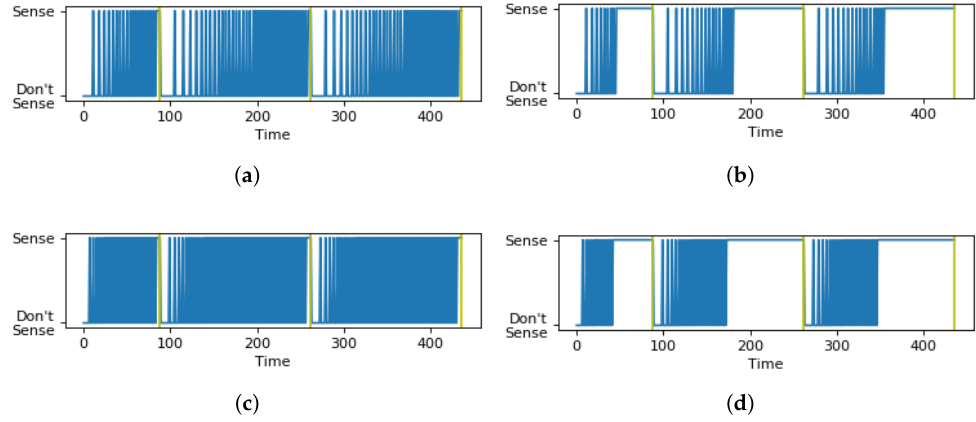
Figure 10. Sensing schedules for ( α , β ) combinations showing the continuous sensor triggering phenomenon for values of ( a ) α = 0.3, β = 0.7; ( b ) α = 0.3, β = 0.8; ( c ) α = 0.8, β = 0.2; and ( d ) α = 0.8, β = 0.3. ( d ) α = 0.8, β =